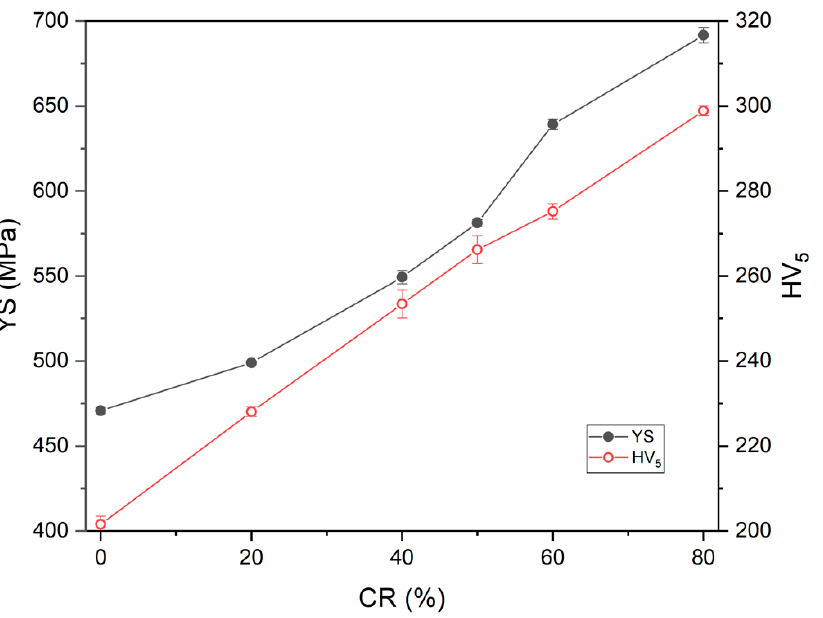
Figure 6. Effect of the CR ratio on hardness HV 5 and yield strength YS measured by means of FIMEC test.